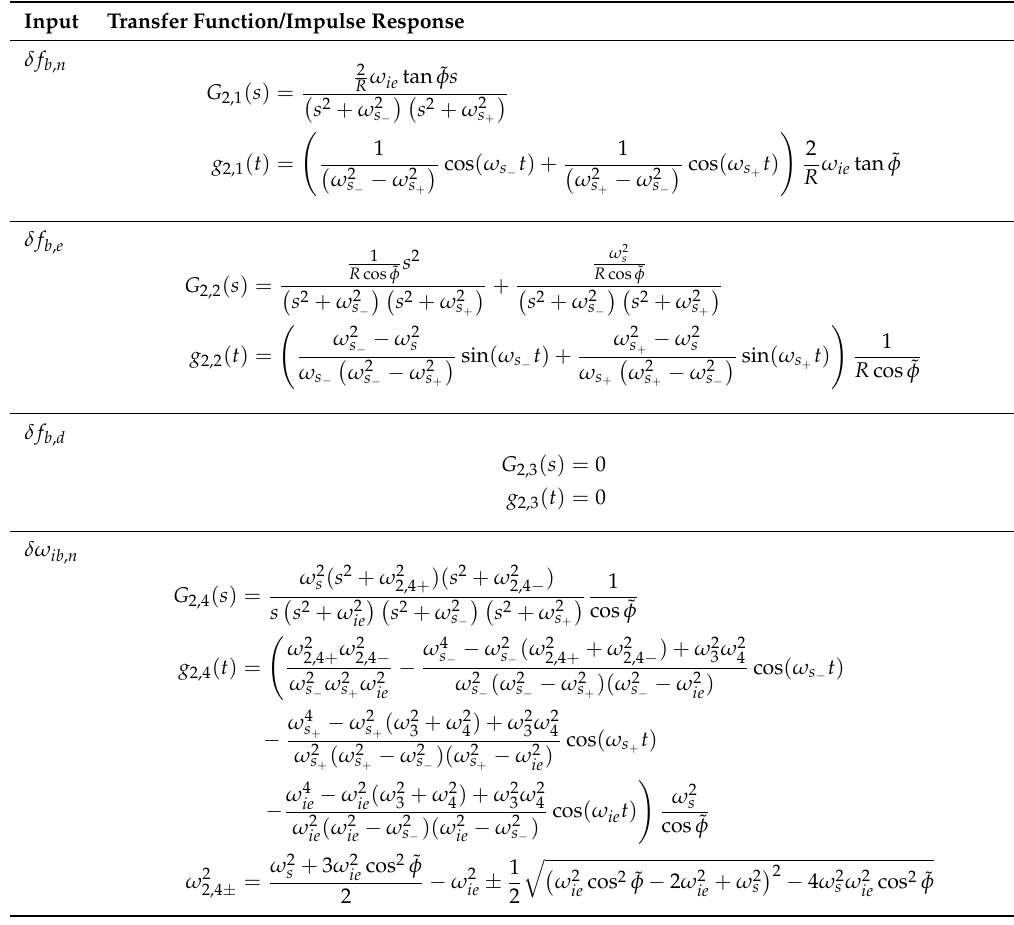
Table A2. Longitude error impulse